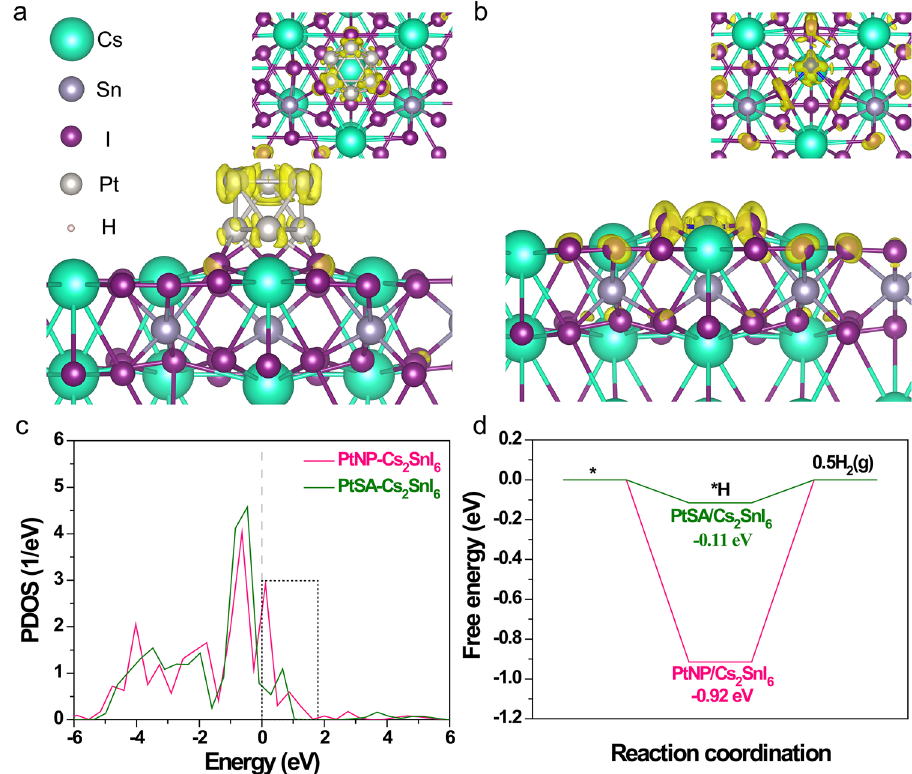
Fig. 5 Charge density distribution and Gibbs energy calculations. The charge density difference maps between before and after photoexcitation: a PtNP/ Cs 2 SnI 6 and b PtSA/Cs 2 SnI 6 . The isosurface of charge density is 0.001e Å − 3 . The insets stand for the top view. The yellow region represents the additional electron distribution. An excess electron was added into the models, which was used to describe the photogenerated electron. c The PDOS (5 d states) of PtNP/Cs 2 SnI 6 and PtSA/Cs 2 SnI 6 . The dashed line stands for the Fermi level. d The calculated energy pro fi le for hydrogen production on PtNP/Cs 2 SnI 6 and PtSA/Cs 2 SnI 6